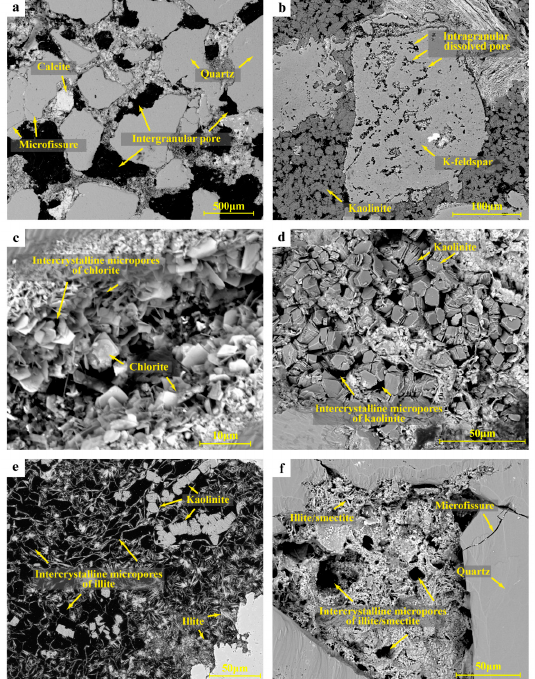
Figure 10. Field emission scanning electron microscopy (FE-SEM) images of different pore types. ( a ) Intergranular pores; ( b ) intragranular pores; ( c ) intercrystalline micropores of chlorite; ( d ) intercrystalline micropores of kaolinite; ( e ) intercrystalline micropores of illite; ( f ) intercrystalline micropores of illite / smectite.